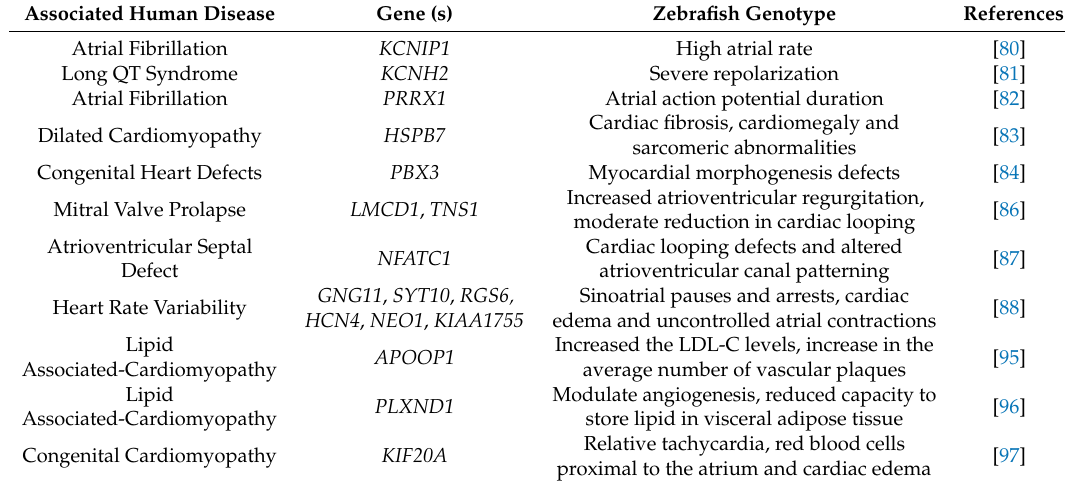
Table 1. An indicative table of GWAS-derived cardiomyopathy related genes studied in zebrafish. Associated Human